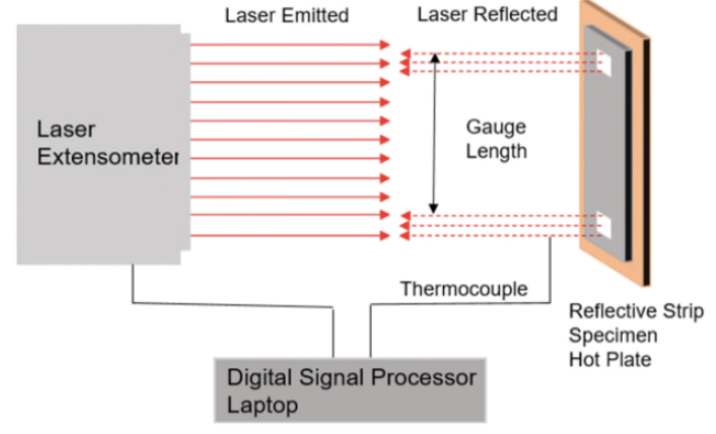
Figure 4. Schematic of thermal strain measurement